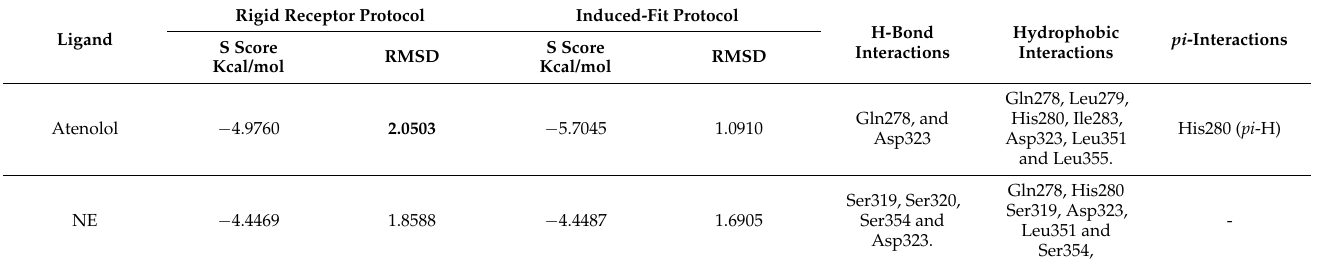
Table 3. Docking results for both norepinephrine and atenolol with E. coli QseC receptor .